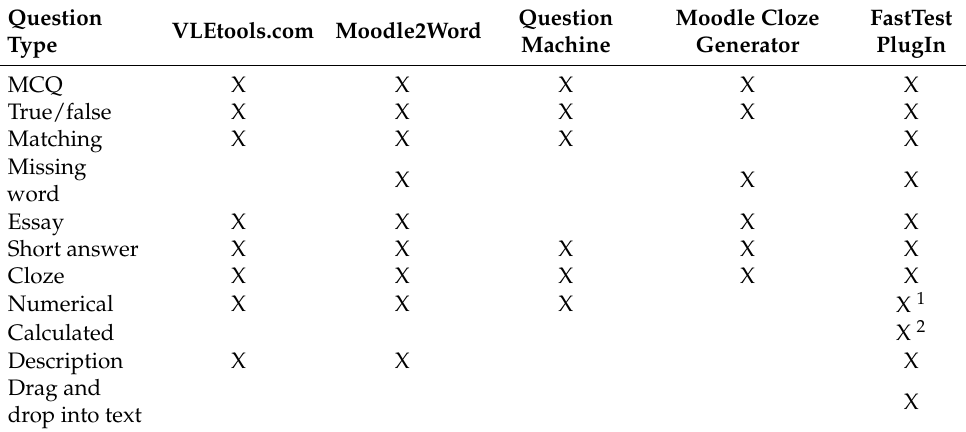
Table 5. Comparison of question types.